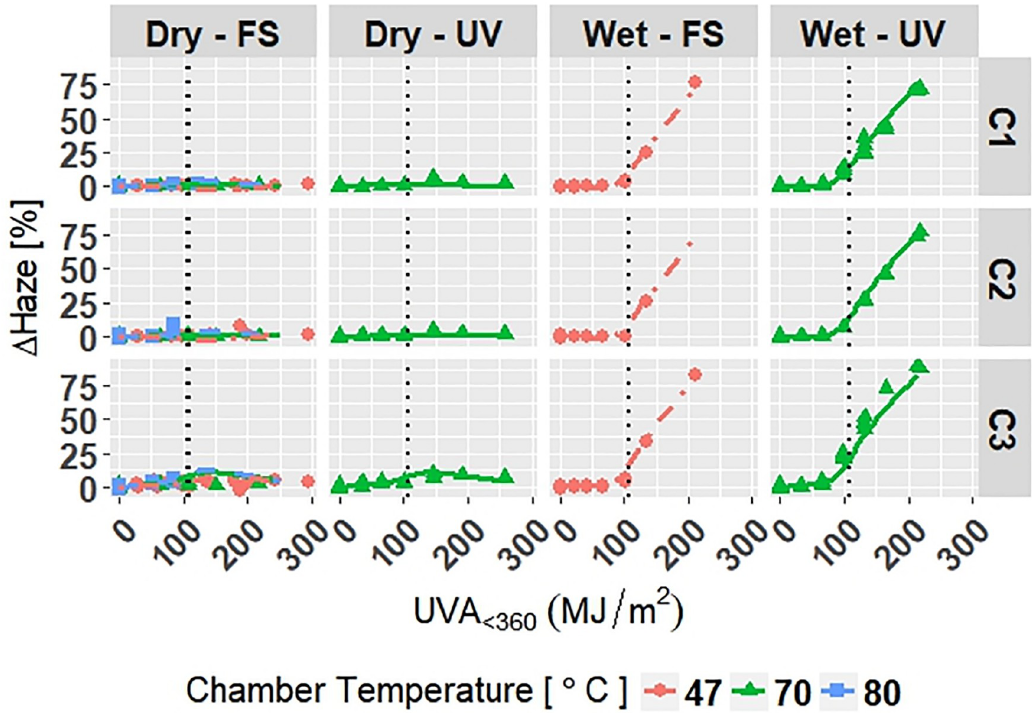
Fig 8. The change in Δ Haze of clear grades of PET under accelerated exposures with the model curves superimposed on the data. Points represent the measured data and solid and dashed lines represent the models. Vertical, dotted lines represent the location of natural spline